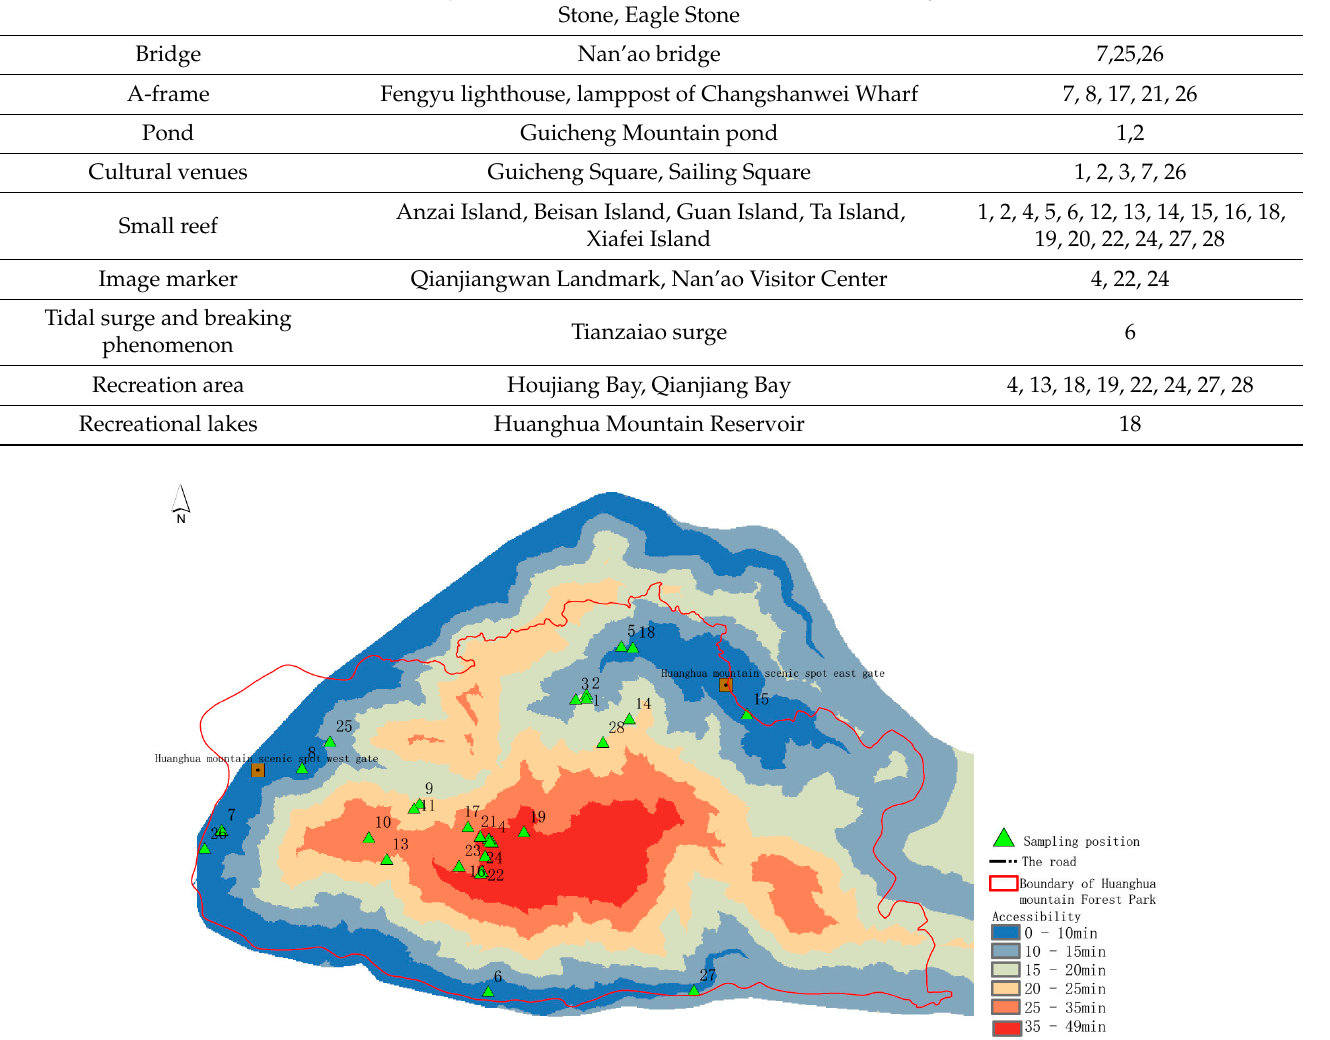
Figure 5. Accessibility analysis of sample plots.